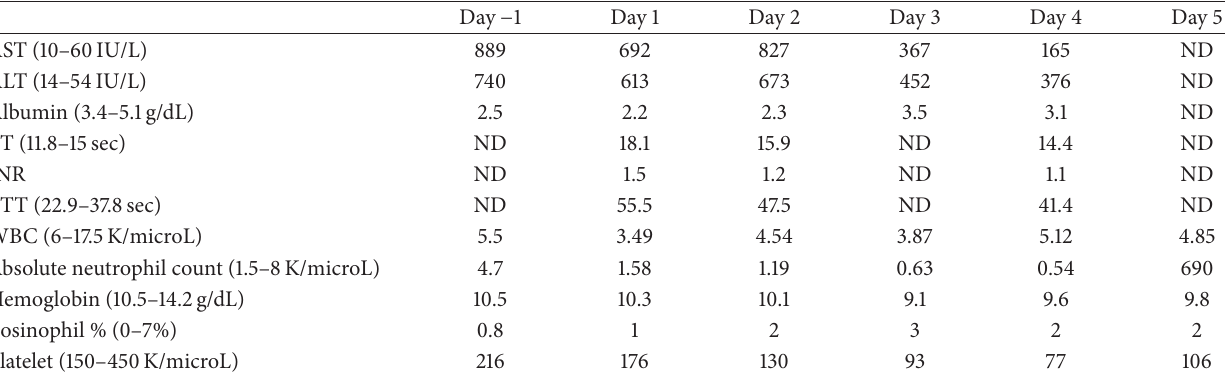
Table 1: Hospital course, lab results. ∗ ND: note done.